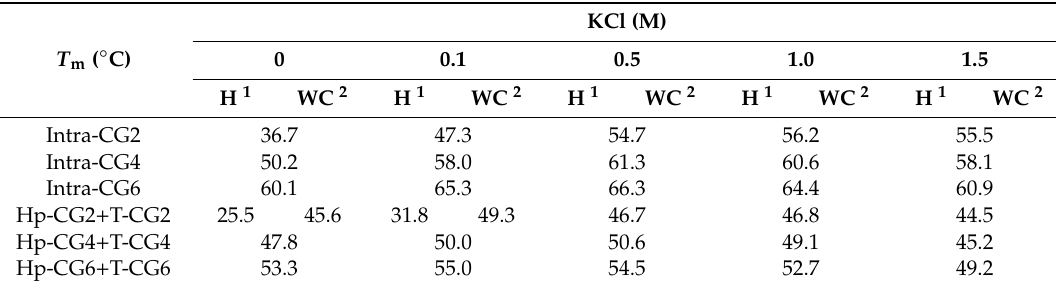
Table 3. Melting temperatures of 20 µ M intramolecular and intermolecular triplexes in the presence of 40 wt% PEG 200 with 0, 0.1, 0.5, 1.0, and 1.5 M KCl.